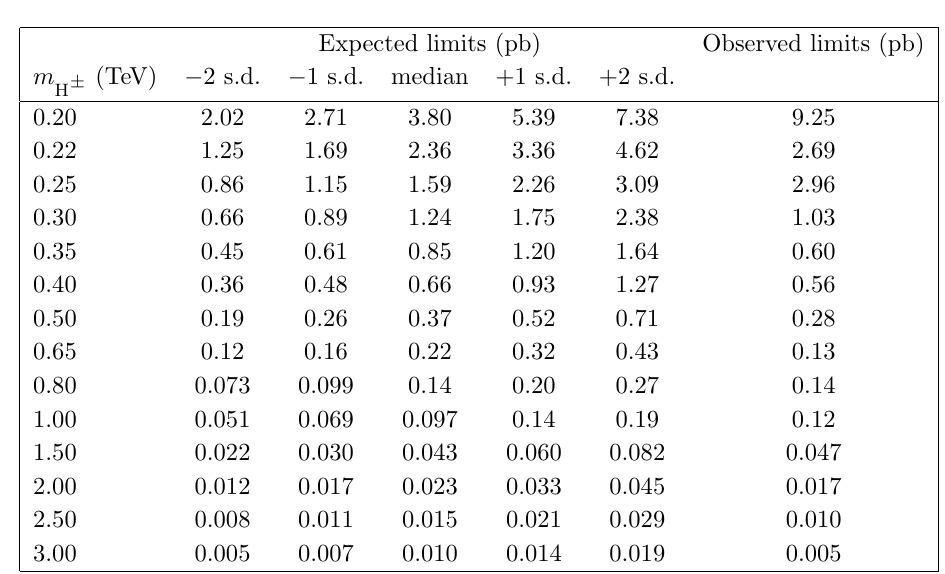
Table 4 . The upper limit at 95% CL on (cid:27) lepton, and dilepton (cid:12)nal